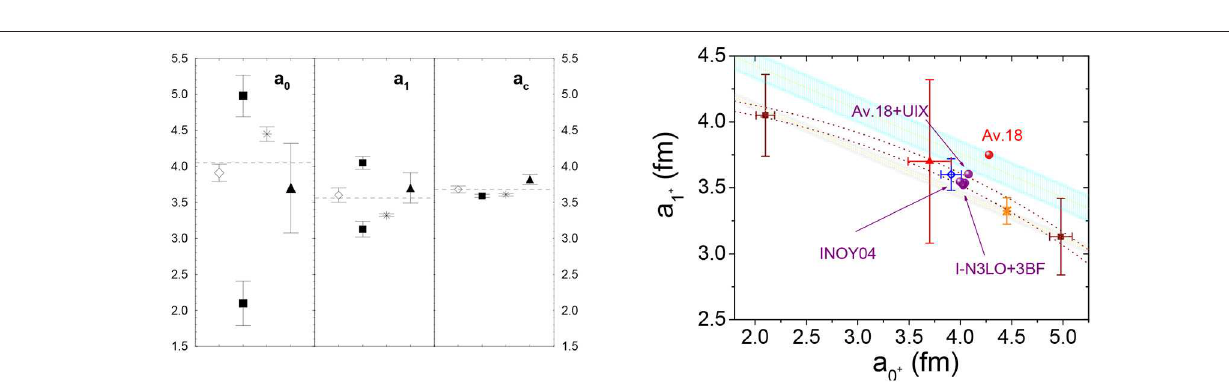
FIGURE 4 | (Left) Experimentally deduced singlet ( a 0 ), triplet ( a 1 ), and coherent ( a c ) n- 3 H scattering lengths. Diamonds from Seagrave et al. [77], up-triangles from Hammerschmied et al. [ 78], squares from Rauch et al. [79], and stars from Hale et al. [80]. (Right) Comparison of the spin-dependent scattering lengths a i , with some theoretical predictions. The measurement of the total cross-section [76] constrains the allowed a 1 ( a 0 ) values to the elliptic band region between the doted curves. The coherent scattering length measurements constrain a 1 ( a 0 ) to a linear band region given by 4 a c = a 0 + 3 a 1 . Notice that two coherent scattering length measurements, the upper band [78] and the lower band [79], are incompatible within their error bars, whereas Hammerschmied et al. [78] is also incompatible with the cross-section measurement of Phillips et al.